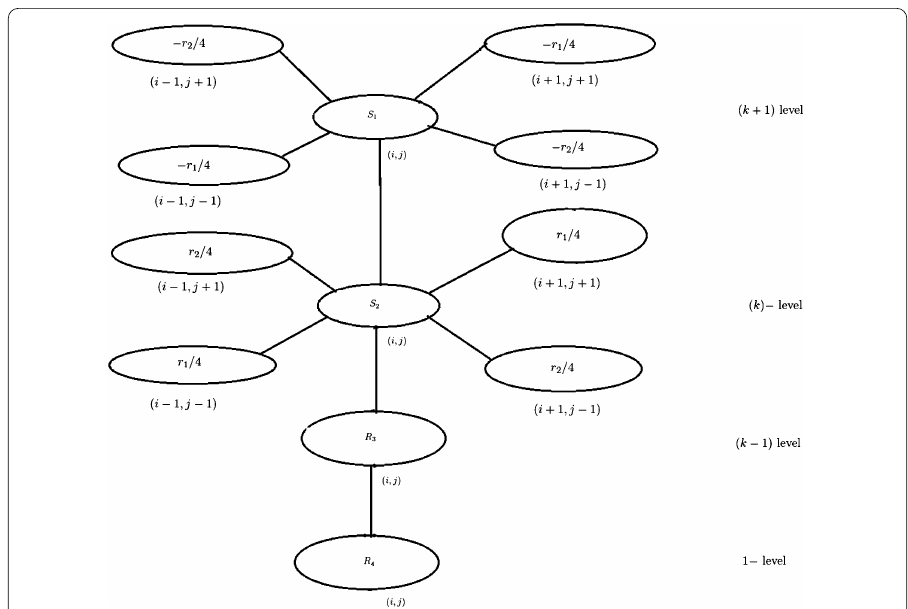
Figure 2 Computational molecule of the FSkG(C-N) iterative scheme